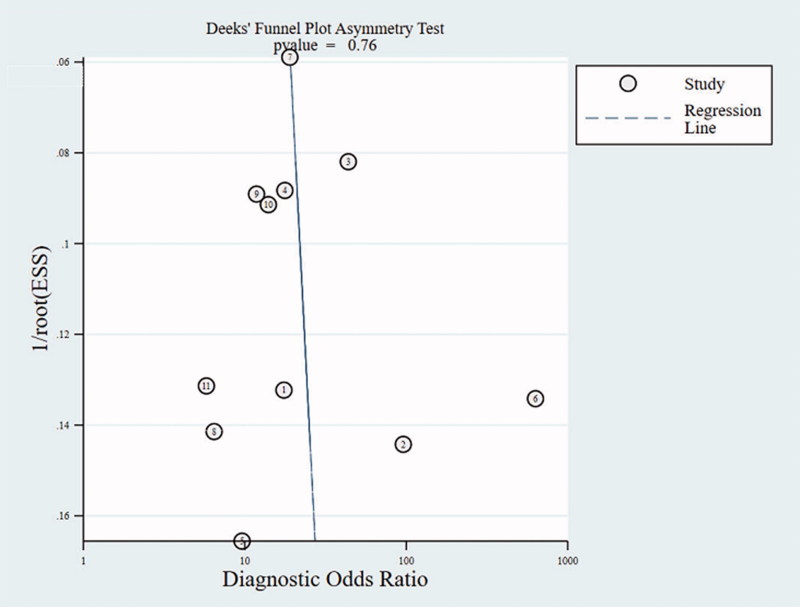
Deed’s funnel plot of cross-sectional study.